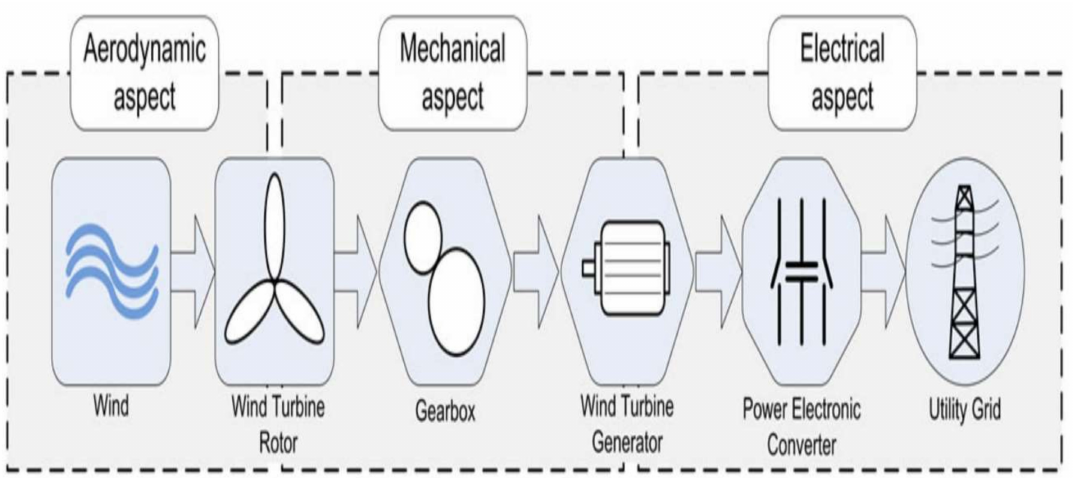
Figure 19. Wind turbine conversion systems